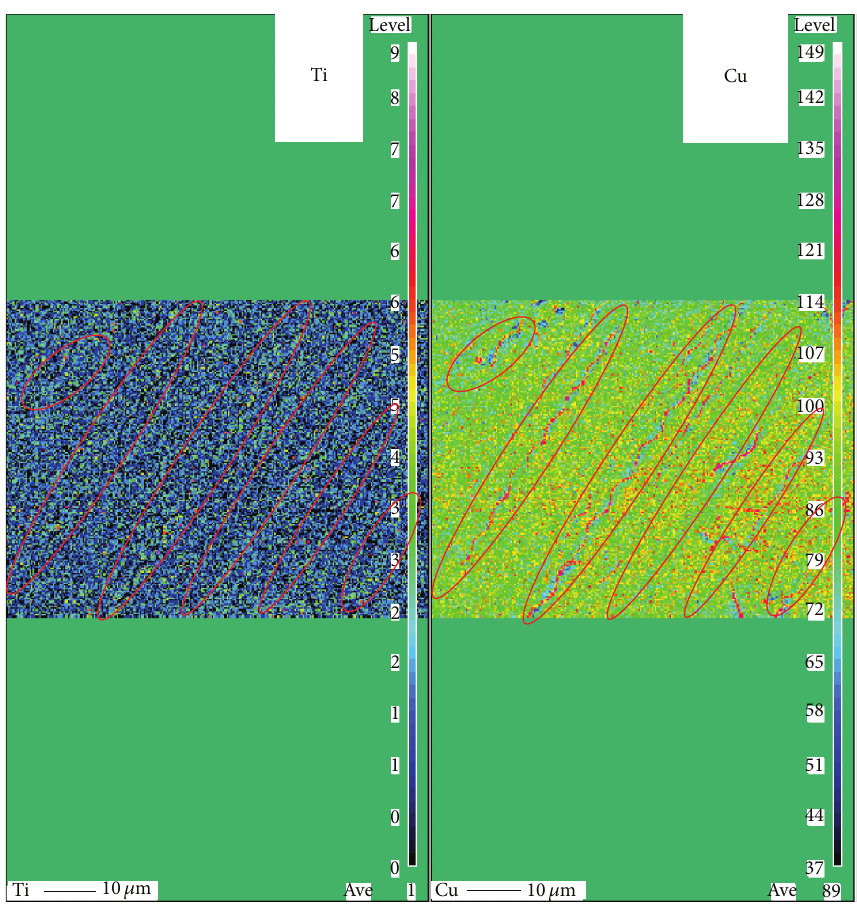
Figure 10: EPMA image of TiO 2 film coated on Cu